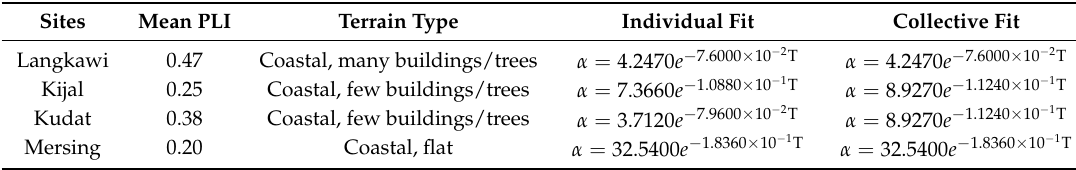
Table 7. The exponential fit for every site with different terrain